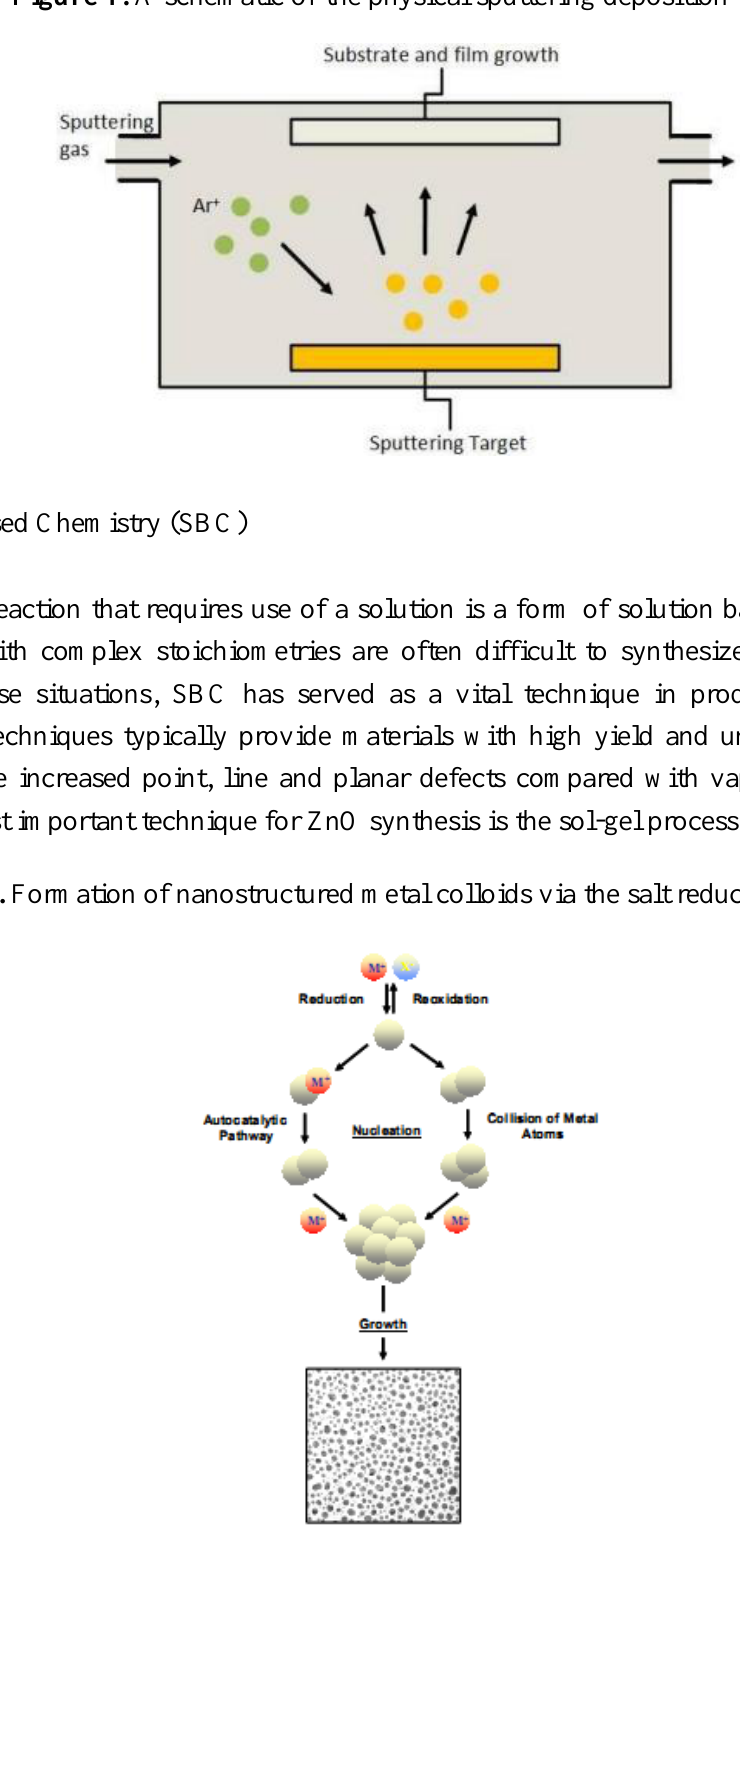
Figure 1. A schematic of the physical sputtering deposition technique.